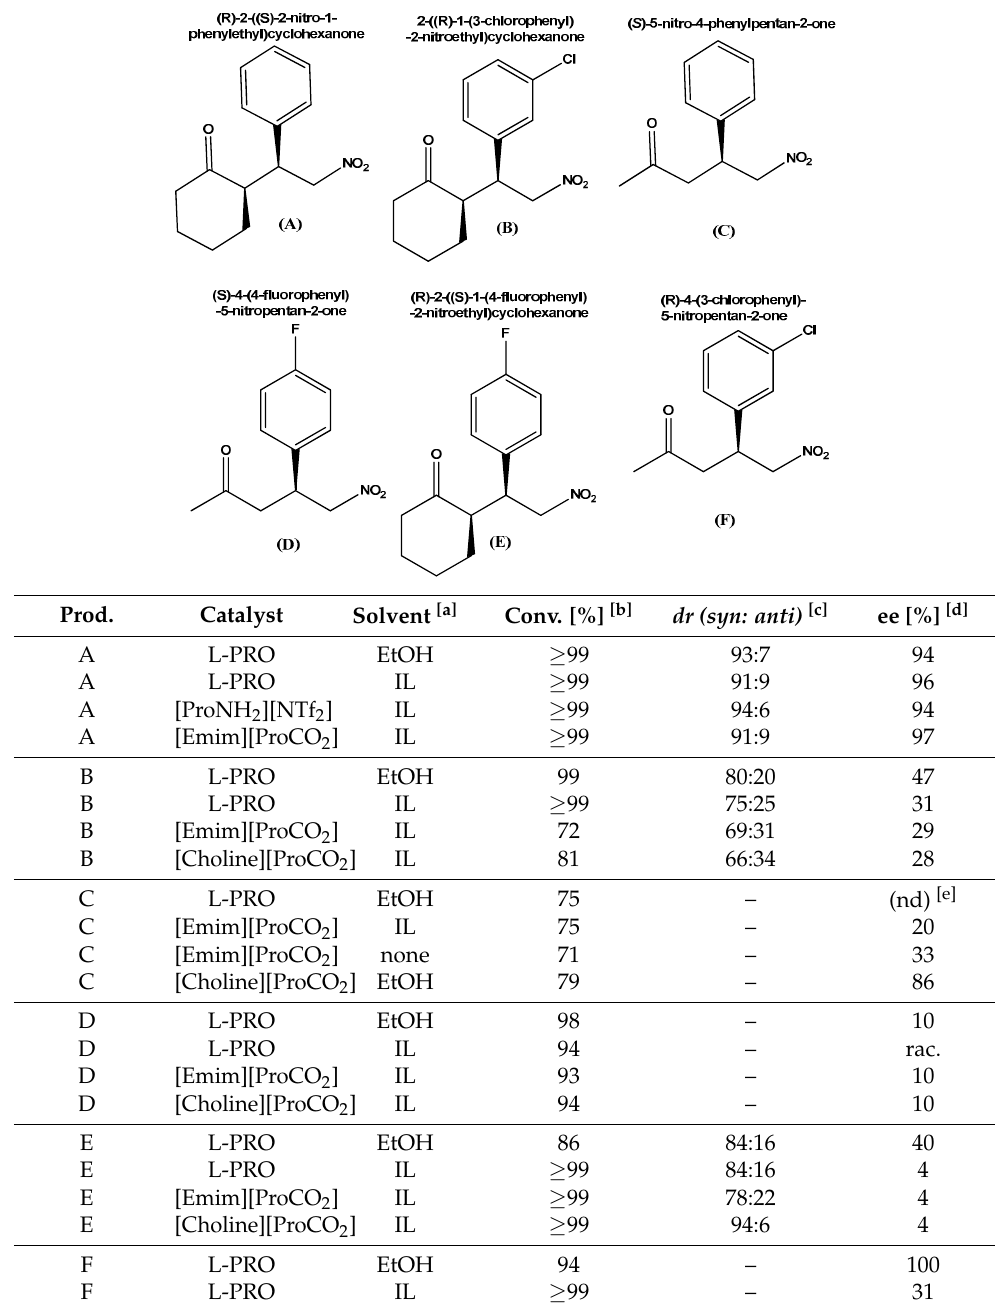
Table 4. Asymmetric Michael reaction with CILs based on L-proline (30 mol%, 48 h) using different substrates.